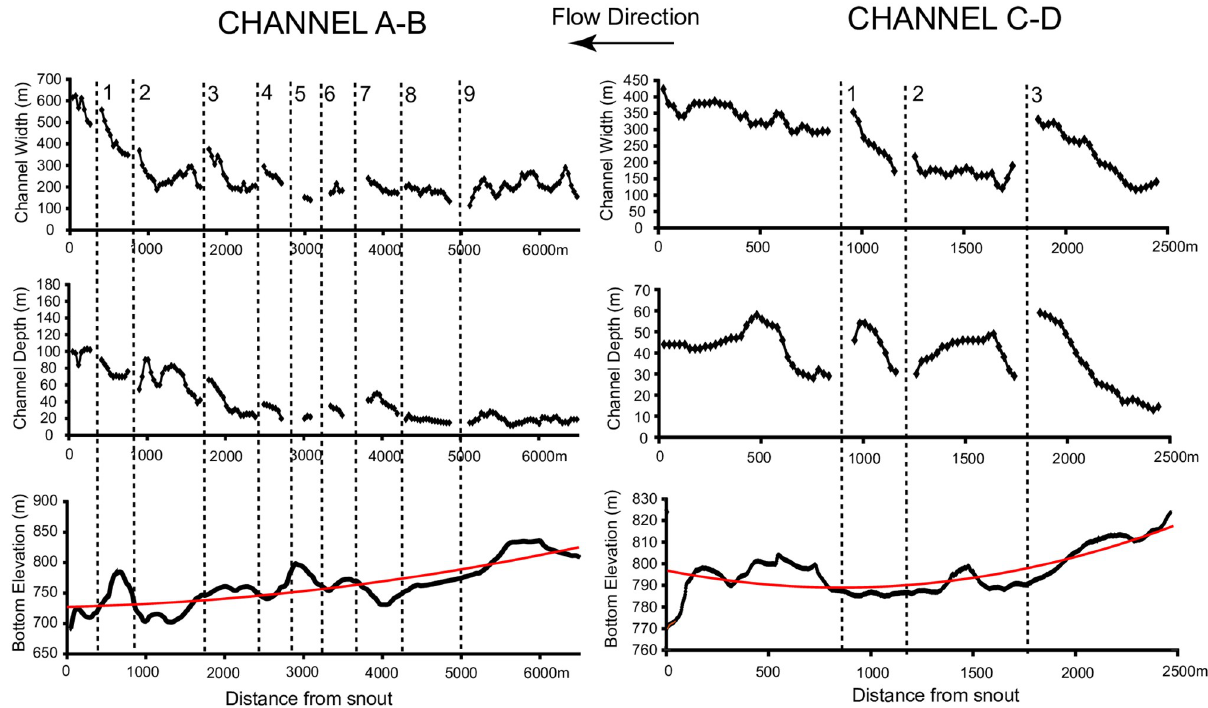
Fig 10. Depth, bottom elevation, and bottom gradient of the two subglacial channels indicated in Fig 1 (channel A-B and channel C-D). The numbers refer to lateral tributaries discharging in the main trunk (see Fig 1). The red lines are a second order polynomial interpolation of the bottom elevation